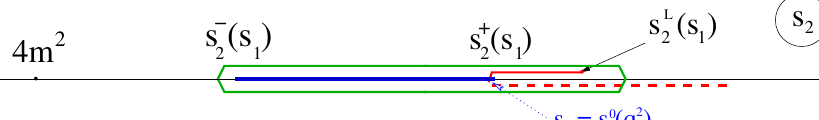
Figure 8. Singularities of the function ∆ ( q 2 , s 1 , s 2 ) in the complex s 2 plane as a function of s 1 for q 2 > 0. ( s ) vs s (This corresponds to the external s 1 and the internal s 2 integration). The trajectory s L 1 1 at fixed 2 ( s ) remains on the unphysical sheet q 2 > 0 is shown by the red line: for s 1 < s 0 the branch point s L 1 2 1 (dashed red line), but, as soon as s 1 > s 0 , it goes onto the physical sheet and moves to the right from 1 the right boundary of the normal cut s + (solid red line). Respectively, for s 1 > s 0 , the contour should 2 1 embrace the point s L , and the integration contour (green line) contains two segments: the “normal” 2 segment from s − to s + (blue line) and the “anomalous” segment from s + to s L (solid red line). The real 2 2 2 2 axis of the variable s 2 is shown as black